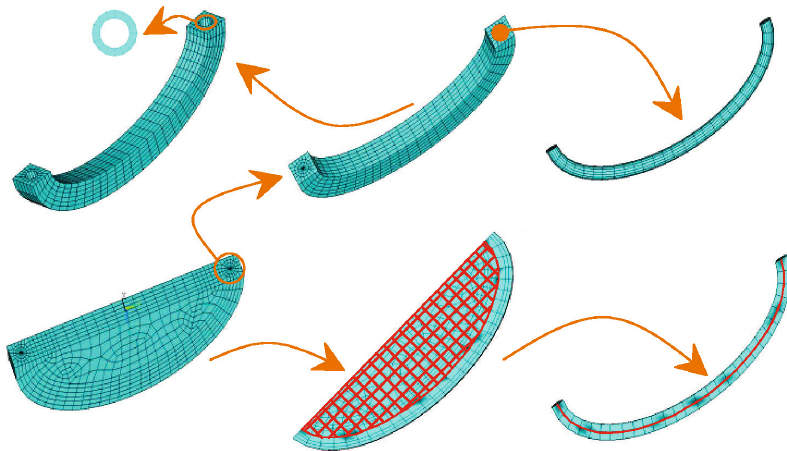
Figure 4. Three-dimensional Finite Element Model of the crack